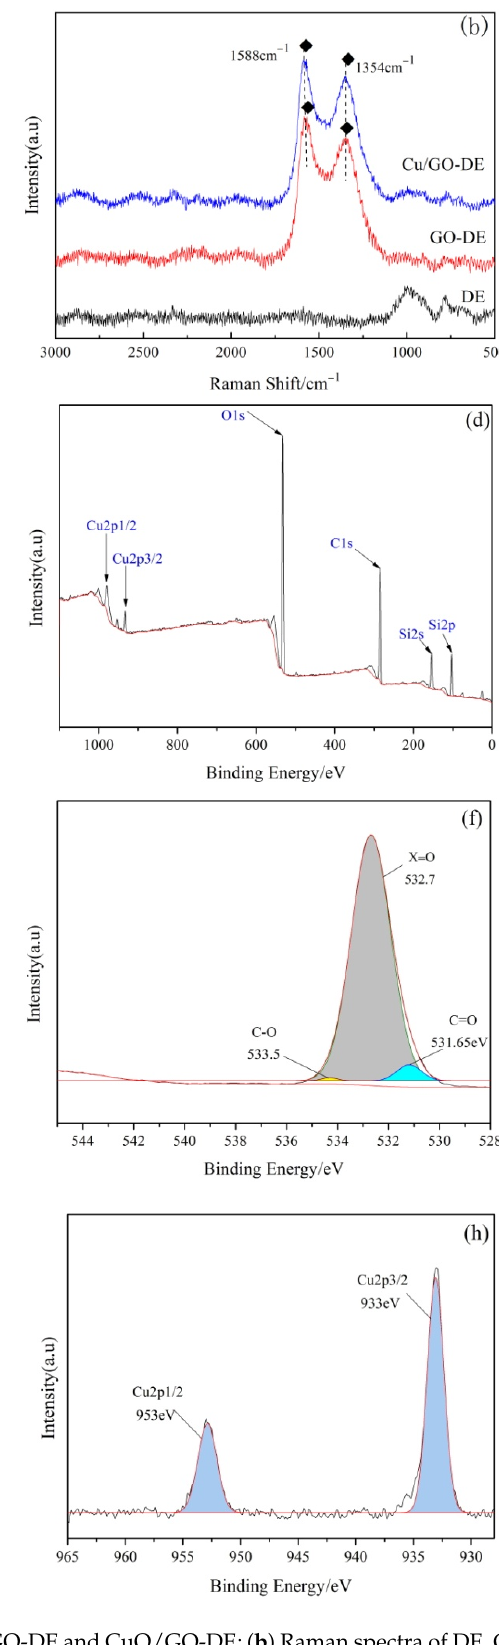
Figure 3. ( a ) FTIR spectra of DE, GO, GO-DE and CuO/GO-DE; ( b ) Raman spectra of DE, GO-DE and CuO/GO-DE; ( c ) XRD patterns of DE, GO, GO-DE and CuO/GO-DE; XPS spectra of CuO/GO-DE: ( d ) total spectrum, ( e ) C 1 s, ( f ) O 1 s, ( g ) Si 2 p and ( h ) Cu 2 p. In order to make sure the chemical state of various elements in the sample, the CuO/GO ‐ DE was tested by XPS. The total spectrum and the characteristic spectrums of each element are shown in Figure 3d–h. In the total spectrum (Figure 3d), it can be seen that the peaks near the binding energies of 103 eV and 150 eV correspond to the charac ‐ teristic peaks of Si 2 p and Si 2 s: the peak with binding energy around 285 eV belongs to the characteristic peak of C 1 s; the peak of binding energy near 532 eV is the characteris ‐ tic peak of O 1 s; the peaks of binding energy near 933 eV and 953 eV are the characteristic peaks of Cu 2 p3/2 and Cu 2 p1/2, respectively, indicating the existence of divalent copper (CuO) in the catalyst. Figure 3e shows the characteristic peaks at the binding energies of 284.8 eV, 286.9 eV and 288.9 eV corresponding to C ‐ C, C ‐ O/C=O and O ‐ C=O [47,51], re ‐ spectively. Figure 3f shows the spectrum of O 1 s with the peaks at 531.65 eV and 532.7 eV representing C=O of GO and the peaks at 533.5 eV representing C ‐ O [38,46]. In Figure 3g, the peak at the binding energy of 103.1 eV corresponds to the characteristic peak of Si 2 p, indicating the main components of DE. The spectrum of Cu 2 p in the sample (Figure 3h) has the characteristic peaks of Cu 2 p3/2 and Cu 2 p1/2 at the binding energies of 933 eV and 953 eV, respectively [52], indicating that CuO exists on the surface of the catalyst and the copper is loaded on the material in the form of CuO. 3.3. Degradation of CIP In order to determine the optimum operating conditions during CIP degradation, a series of single ‐ factor experiments were carried out at different pH values, initial CIP concentration, catalyst dosage, H 2 O 2 concentration and reaction temperature. pH value is an important factor affecting the catalytic performance of CuO/GO ‐ DE. Figure 4a shows the degradation capacity of the catalyst under different pH conditions. It can be seen that the catalytic system achieved high degradation efficiencies at pH ranging from 4 to 10, and at pH of 7, it can reach the highest CIP degradation ratio (99.9% after 240 min of reaction). Under acidic conditions, ∙ OH generated from catalyzing H 2 O 2 by CuO/GO ‐ DE is the main oxidant to oxidize the CIP under neutral and alkaline condi ‐ tions, although the amount of ∙ OH reduced due to H 2 O 2 decomposing to H 2 O and O 2 , Cu (I) will be oxidized by H 2 O 2 and O 2 to high valence Cu (III) with strong oxidizability [53–56], which plays an important role as well as ∙ OH does in the degradation of CIP.